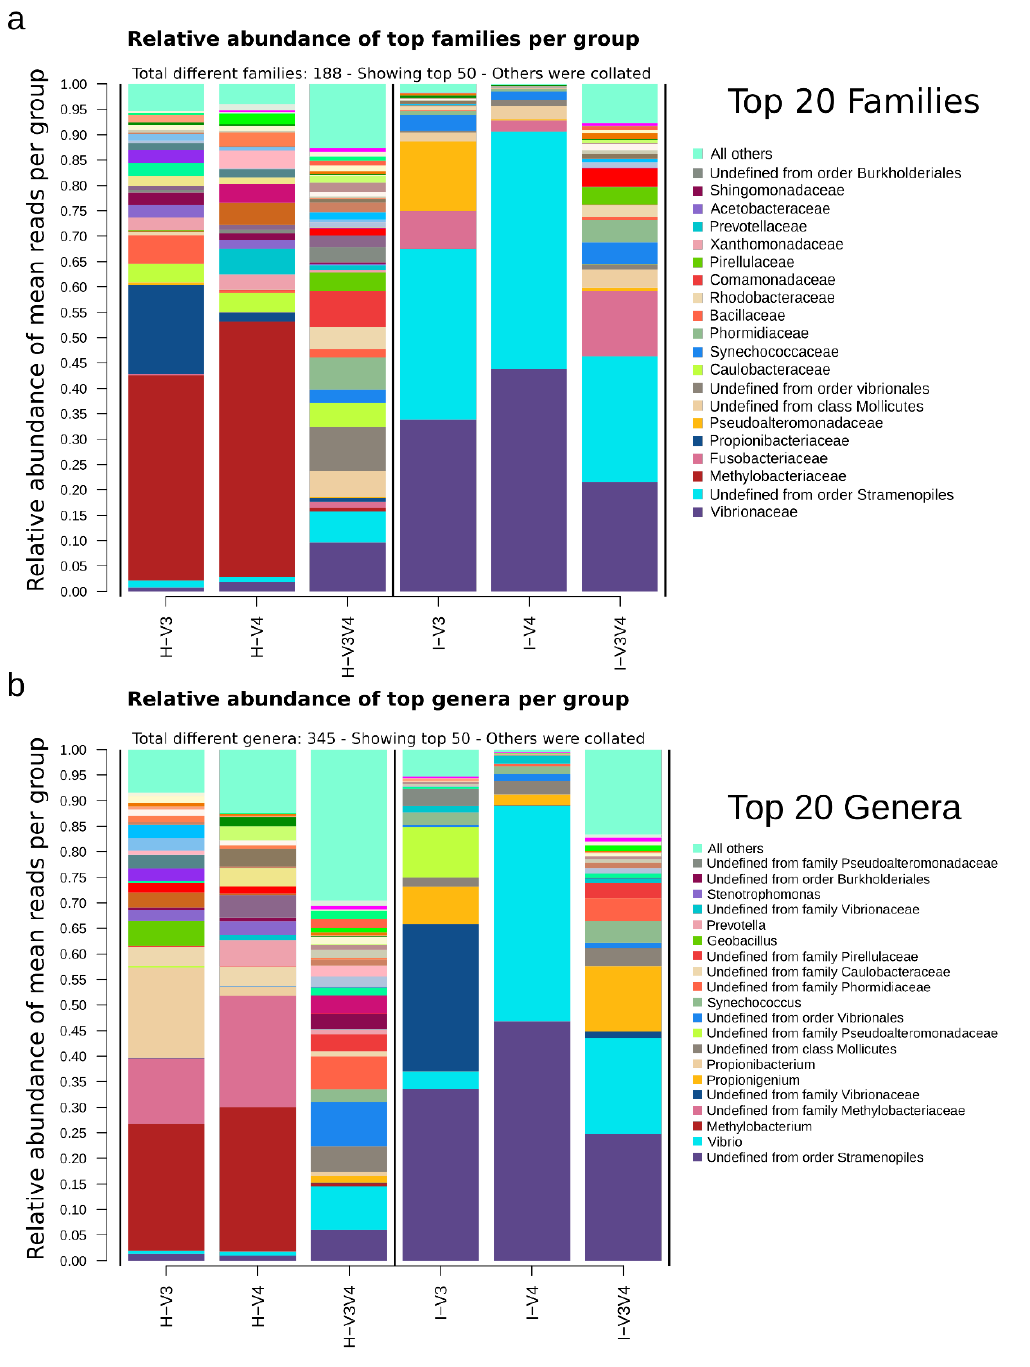
Figure 7. Relative abundance at Family and genus per region-organ groups. Taxa are ordered by abundance. Only the top 20 were shown, and the sum of the rest was shown as all others. ( a ) Family and ( b ) genus.